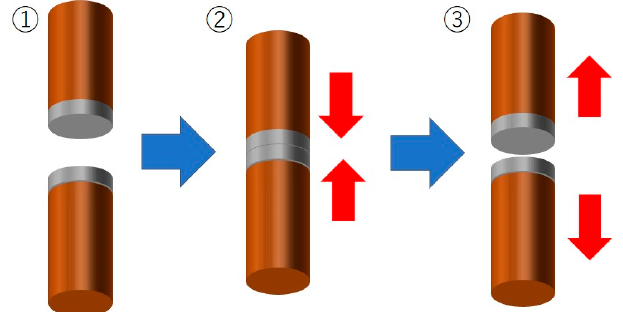
Figure 1. Experimental process to evaluate the solderability of electrodeposited Sn-Zn alloy films synthesized on Cu rods. ( 1 ): Electrodeposition of Sn-Zn alloy films on a cross-section of Cu rods. ( 2 ): Butt-joint of Cu rods by applying a constant pressure. ( 3 ): Tensile test to evaluate the solderability.